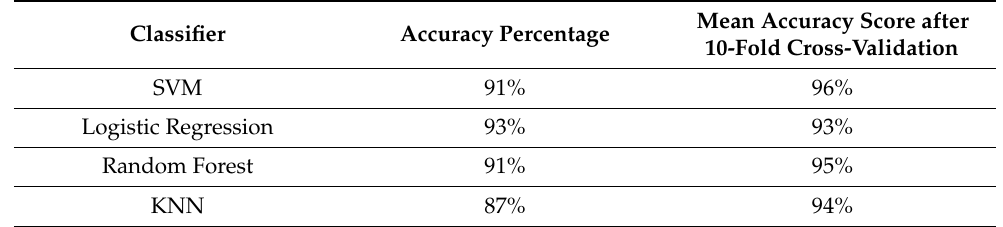
Table 10. Accuracy for each